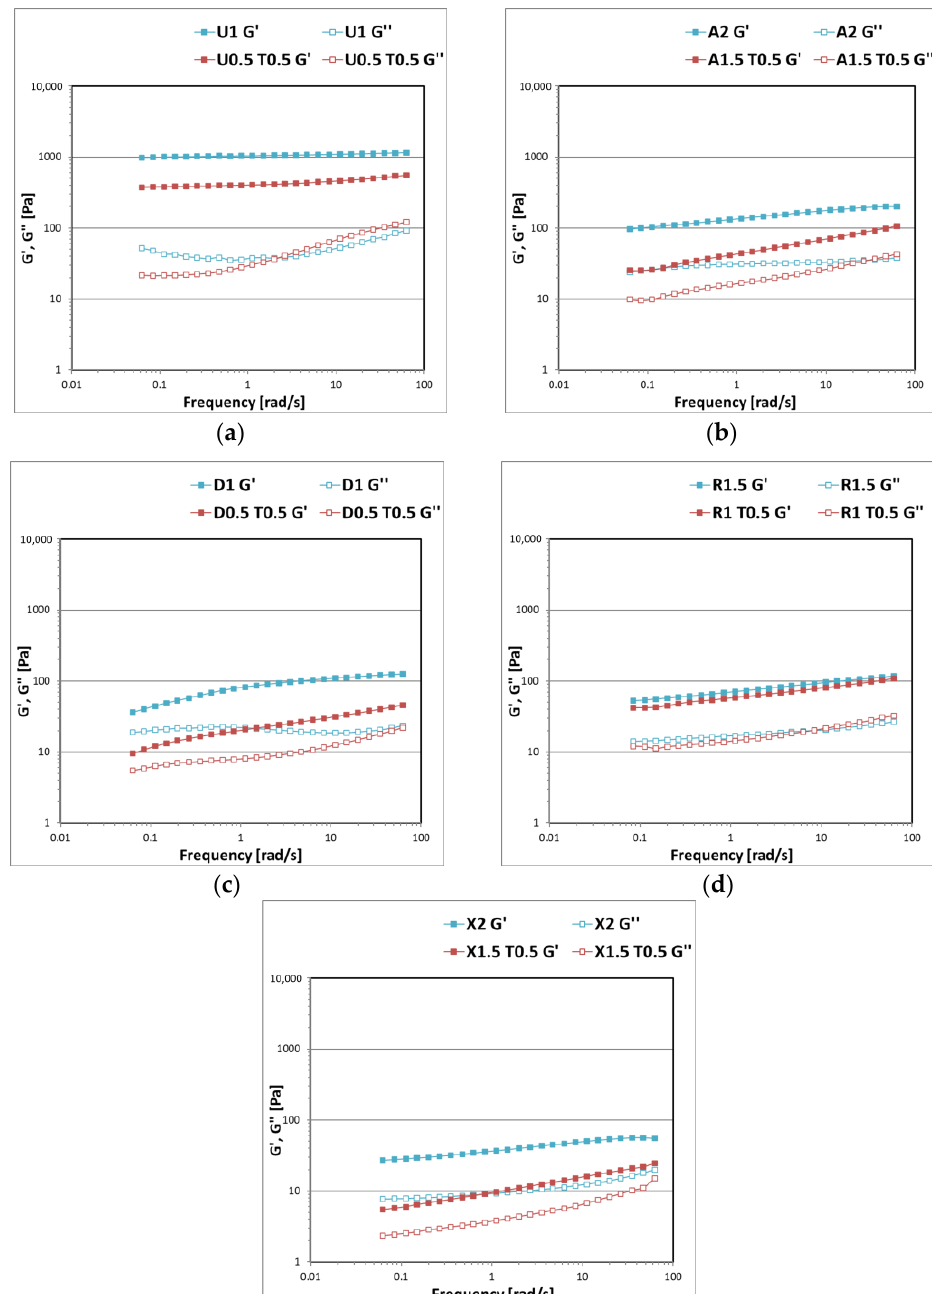
Figure 1. The t rend of elastic G′ and viscous G″ moduli in the function of the frequency applied for samples containing a weak-gel polysaccharide alone and in association with tamarind seed poly- saccharide (T): ( a ) comparison between the gel containing U at 1% w / w (U1) and the gel containing U at 0.5% w / w with T at 0.5% w / w (U0.5 T0.5); ( b ) comparison between the gel containing A at 2% w / w (A2) and the gel containing A at 1.5% w / w with T at 0.5% w / w (A1.5 T0.5); ( c ) comparison between the gel containing D at 1% w / w (D1) and the gel containing D at 0.5% w / w with T at 0.5% w / w (D0.5 T0.5); ( d ) comparison between the gel containing R at 1.5% w / w (R1.5) and the gel containing R at 1.5% w / w with T at 0.5% w / w (R1.5 T0.5); ( e ) comparison between the gel containing X at 2% w / w (X2) and the gel containing X at 1.5% w / w with T at 0.5% w / w (X1.5 T0.5).